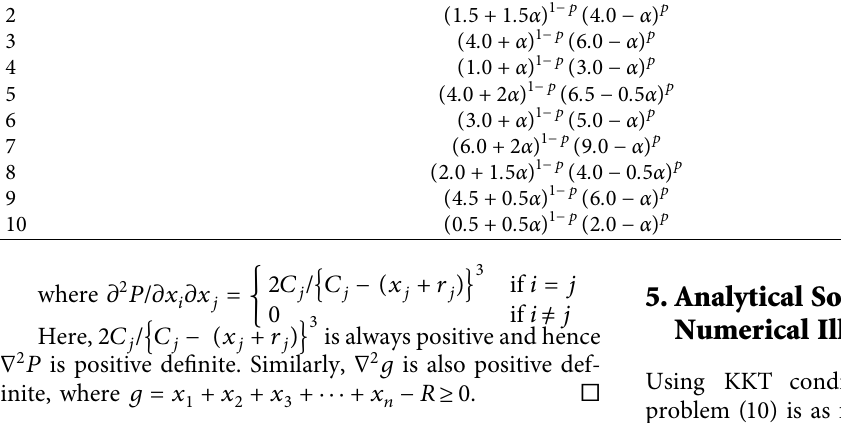
Table 3: Additional traffic and processing rate of each server in terms of parametric representation. Router ( j